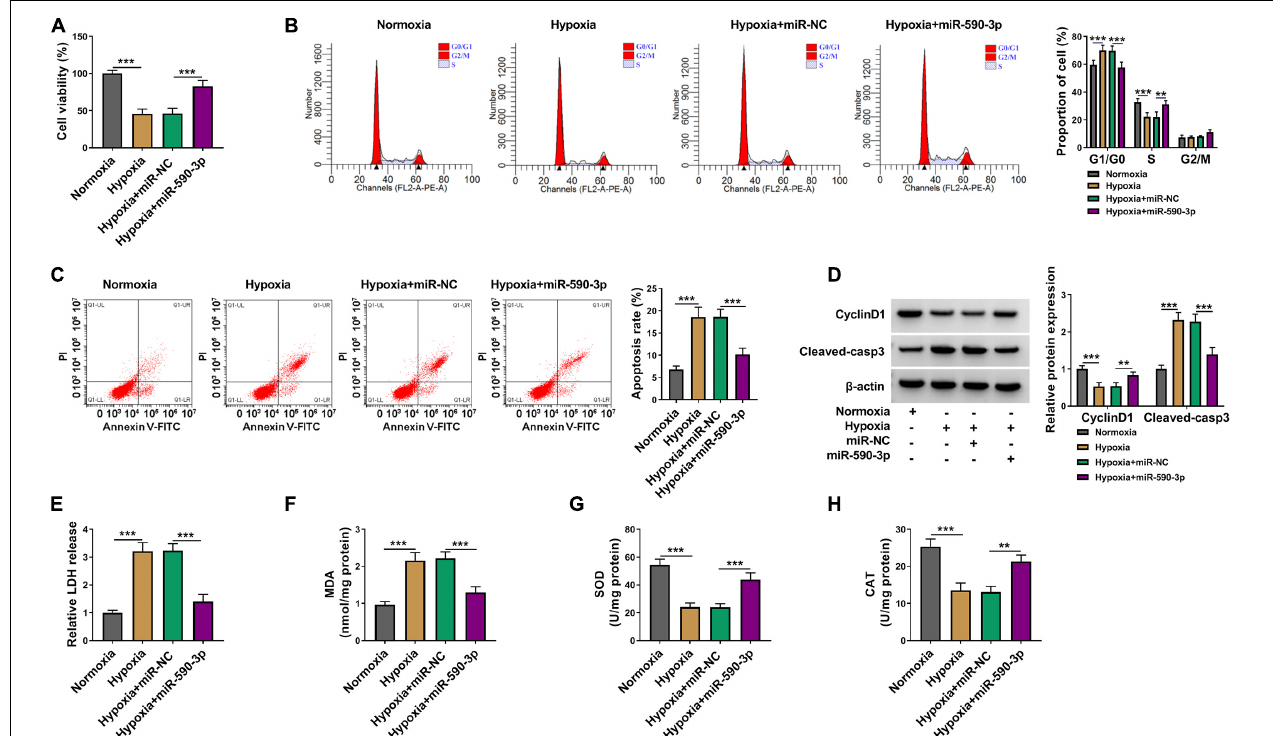
FIGURE 4 | The regulation of miR-590-3p overexpression on cardiomyocytes injury induced by hypoxia. AC16 cells were transfected with miR-NC or miR-590-3p mimic, followed by treated with hypoxia. Normoxia-treated AC16 cells were used as control. (A) Cell viability was determined using CCK8 assay. (B,C) Cell cycle distribution and cell apoptosis were detected by flow cytometry. (D) WB analysis was performed to evaluate the protein levels of CyclinD1 and Cleaved-casp3. (E–H) The levels of LDH, MDA, SOD, and CAT were determined using corresponding Assay Kits. ** P < 0.01, *** P < 0.001.